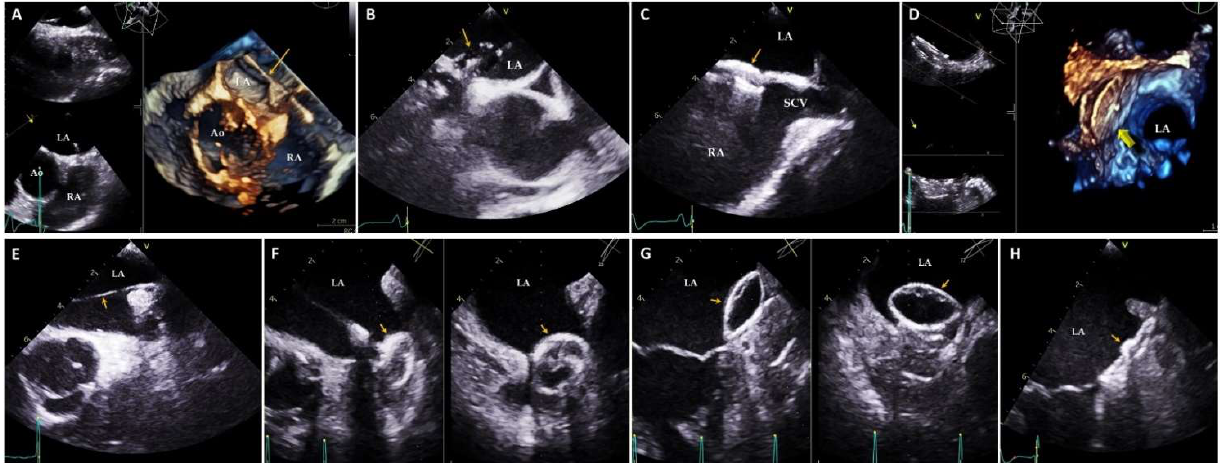
Figure 6. TEE images during invasive procedures in the hemodynamics laboratory. ( A ) 3D TEE image showing crossing of the guidewire (yellow arrow) through the atrial septum. ( B ) 2D TEE image demonstrating the inflated balloon (yellow arrow) through the patent foramen ovale for the sizing of the device to be implanted. ( C ) 2D TEE Midesophageal bicaval plane image depicting the patent foramen ovale closure device (yellow arrow) properly positioned. ( D ) 3D TEE image showing correct patent foramen ovale closure device (yellow arrow) placement from the left atrial view. ( E ) 2D TEE Midesophageal aortic valve short axis view illustrating the catheter (yellow arrow) in the LA resting on the left superior pulmonary vein. ( F ) 2D TTE multiplanar image demonstrating the lobe (yellow arrows) deployment of the atrial appendage closure device. ( G ) 2D TTE multiplanar image showing the implanted atrial appendage closure device (yellow arrows) while traction maneuvers are performed to assess the correct positioning of the device. ( H ) 2D TTE image showing the appendage closure device (yellow arrow) correctly positioned at the end of the procedure. Ao: Aorta; LA: Left atrium; RA: Right atrium; SCV: Superior cava vein.